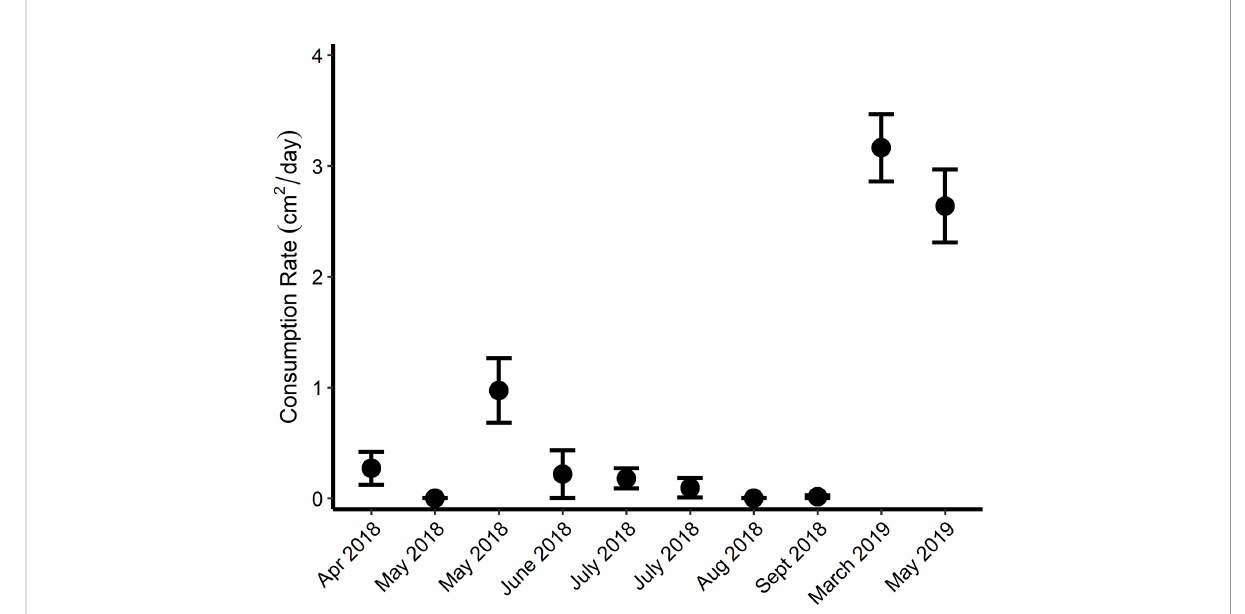
FIGURE 5 Consumption rates, cm 2 day -1 , (± 1 SE) of monthly turtlegrass ( Thalassia testudinum ) tethering